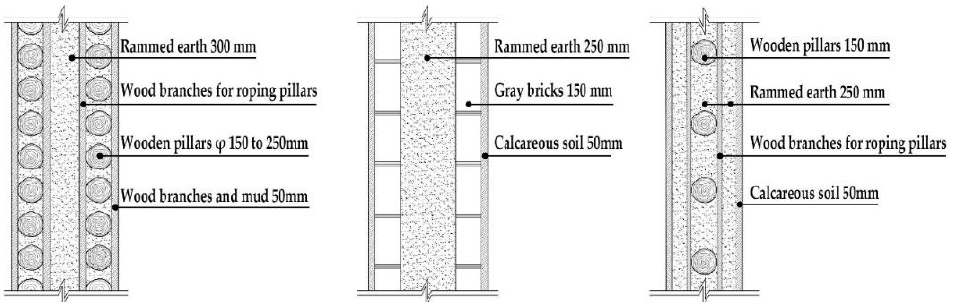
Figure 1. The construction of material layers of exterior walls for three models (from left to right, cross section of F10 in the Fenglin site, F6 in the Lantoubao site, and Palace 4 in the Shangjing city sites).